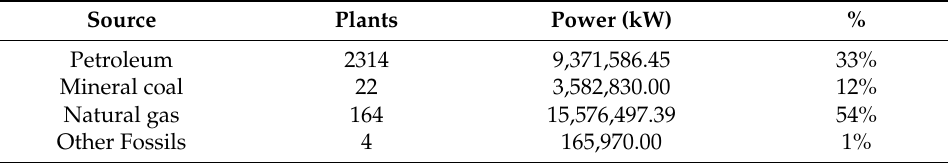
Table 1. Thermoelectric power plants of fossil origin in operation in